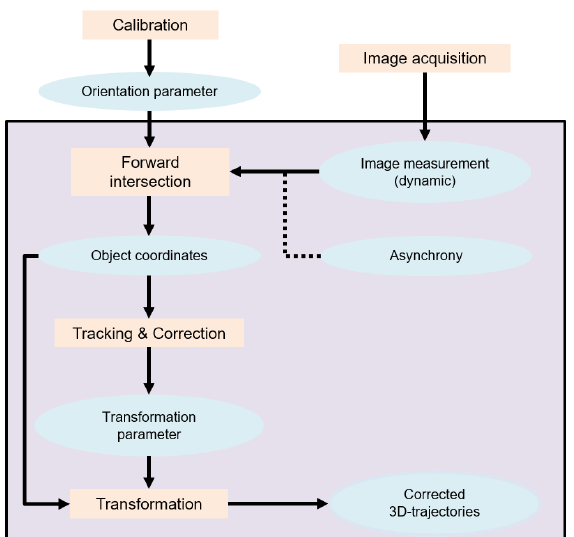
Figure 4 . Workflow of the photogrammetric measurement system. Table 2 . Standard deviation of interior and exterior orientation.